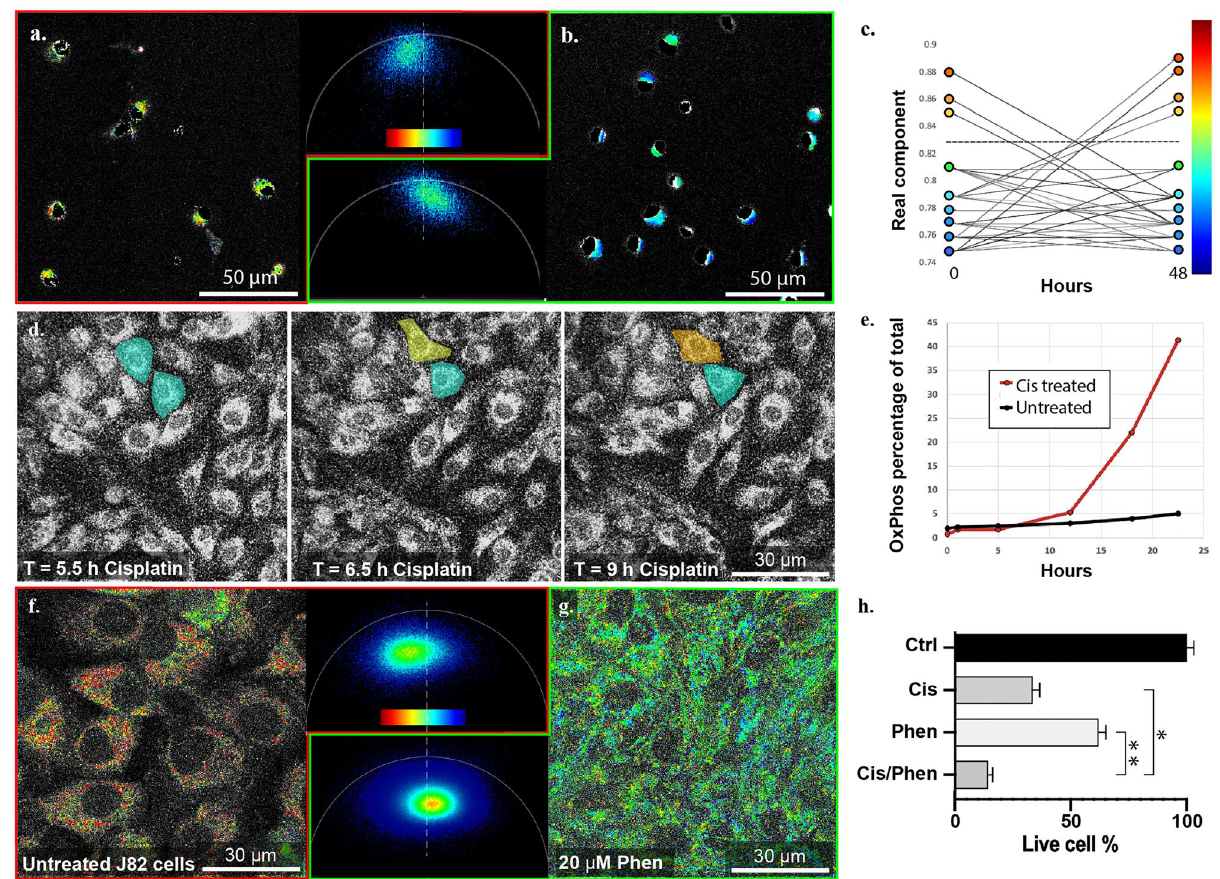
Figure 3. Single-cell analysis of metabolic states. ( a , b ) J82 cells were sorted into SP and NSP cultures by FACS and analyzed in FLIM phasors. SP cells ( a ) have a phasor distribution that describes more OxPhos metabolic states whereas NSP cells ( b ) have a phasor distribution that describes more glycolytic metabolic. The dashed line in the phasor panels of a and b represents an identifiable boundary between NSP and SP FLIM signals, and the color scale bar applies to the cell images of ( a ) and ( b ). ( c ) In unsorted J82 cell culture, we tracked the metabolism of 35 cells for 48 h after seeding and plotted the real component for centers of mass for 9 cells demonstrating shifts in metabolic states from OxPhos to glycolytic states (3 cells), from glycolytic to OxPhos (4 cells) and no change (2 cells). The chart was created in Excel using data input from Leica LAS-X software and the color scale-bar with similarly colored circles were generated in Adobe Illustrator. ( d ) In J82 cells treated with cisplatin at IC50, we tracked a cell that shifted quickly from glycolytic (top cyan cell) to an OxPhos state (same cell, yellow and orange) whereas a neighboring cell remained glycolytic (lower cyan cell). Cell colors reflect real metabolic states determined by phasor position relative to the color scale bar in ( a ) and ( b ). ( e ) When analyzed in total from initial treatment to 22.5 h post treatment, the percentage of cells that are OxPhos rises to 42% (red data points) compared with 5% for untreated cells (black data points). ( f , g ) J82 cells were cultured in the absence (f) or presence of phenformin ( g ) and analyzed in FLIM phasors, demonstrating a clear shift away from OxPhos ( f ) and toward glycolytic ( g ) metabolism. ( h ) Co-treatment with cisplatin and phenformin